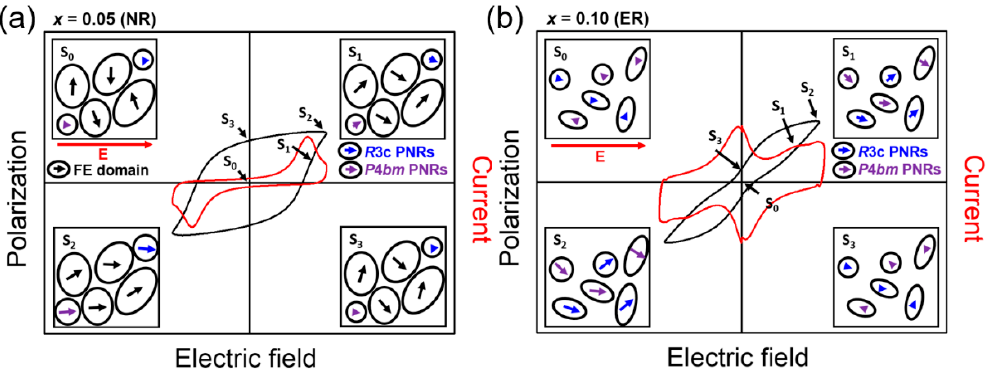
Figure 9. A proposed schematic diagram of polar nano-regions (PNRs) formation in BNKT ceramics with P - E and current–electric field ( I - E ) loops for x = 0.05 (NR) and x = 0.10 (ER).